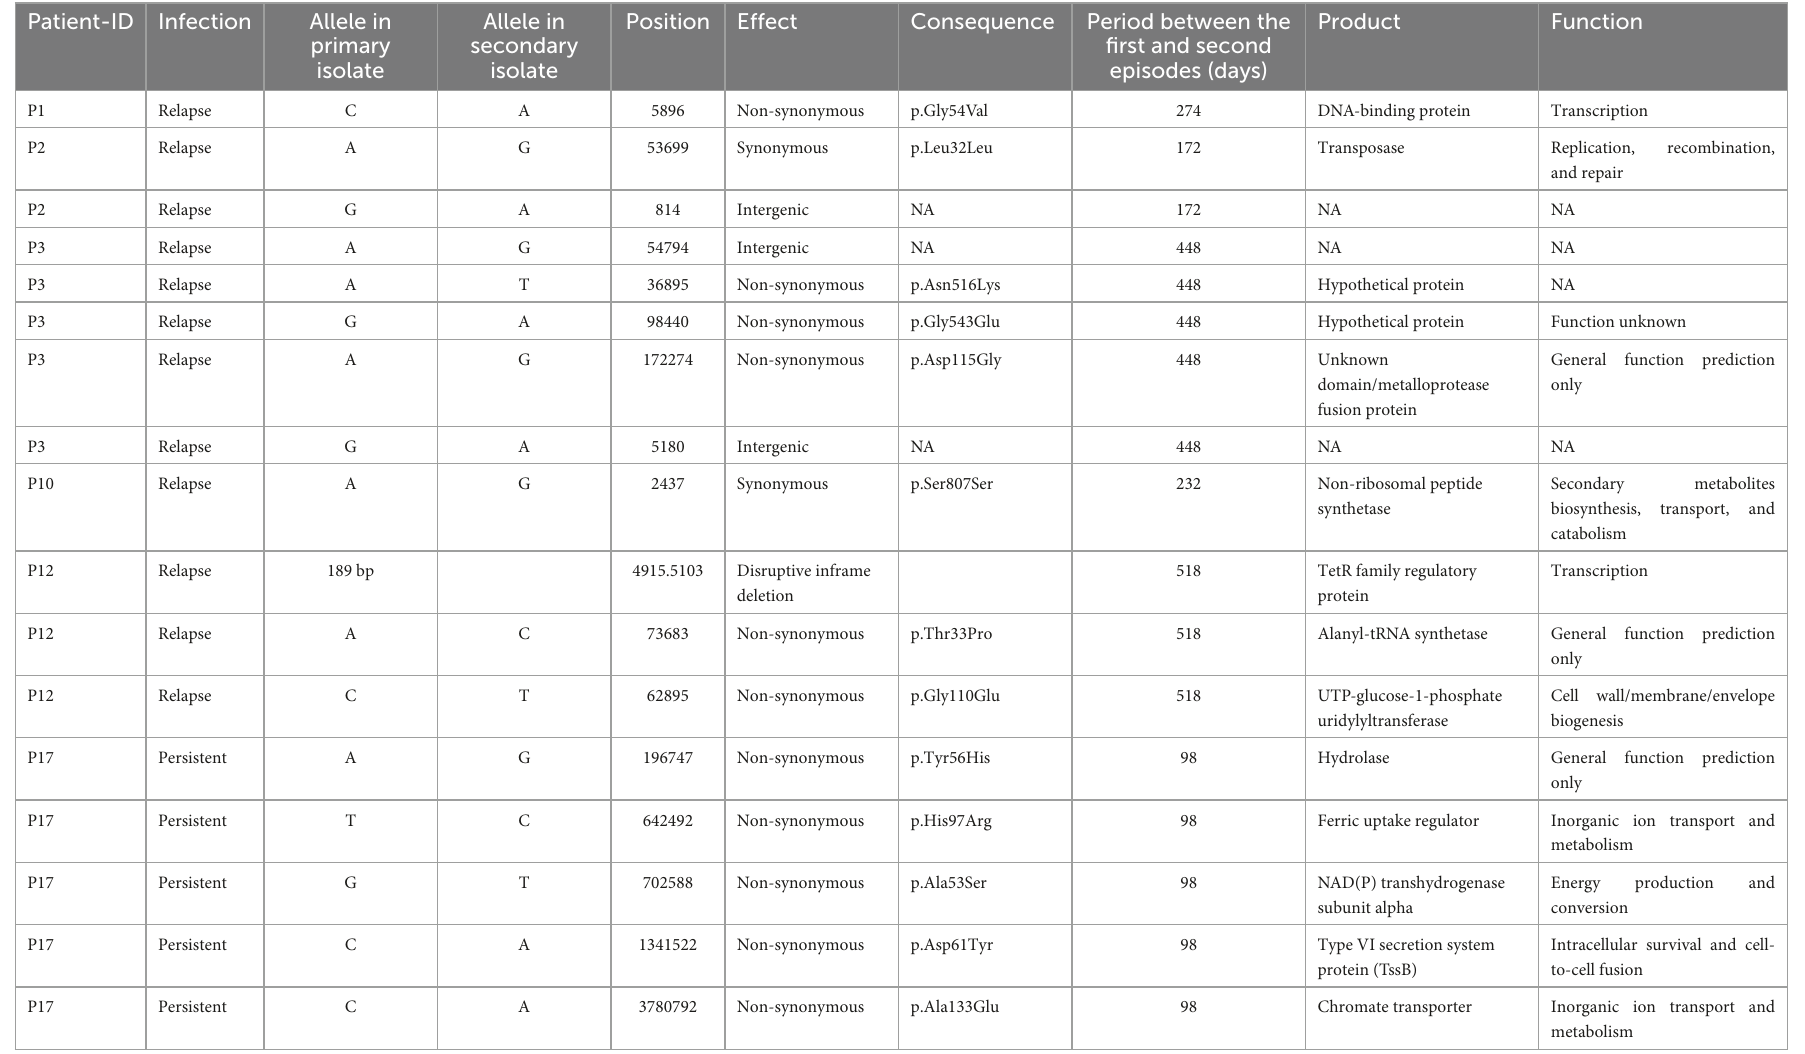
TABLE 2 Characteristics of all within-host mutation in 6 pairs of Burkholderia pseudomallei isolates from patients with relapse and persistent